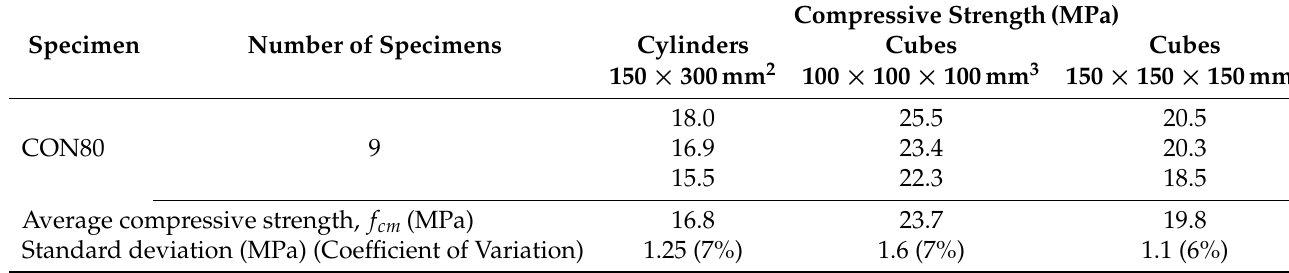
Table 5. Compressive strength of the low-strength standard